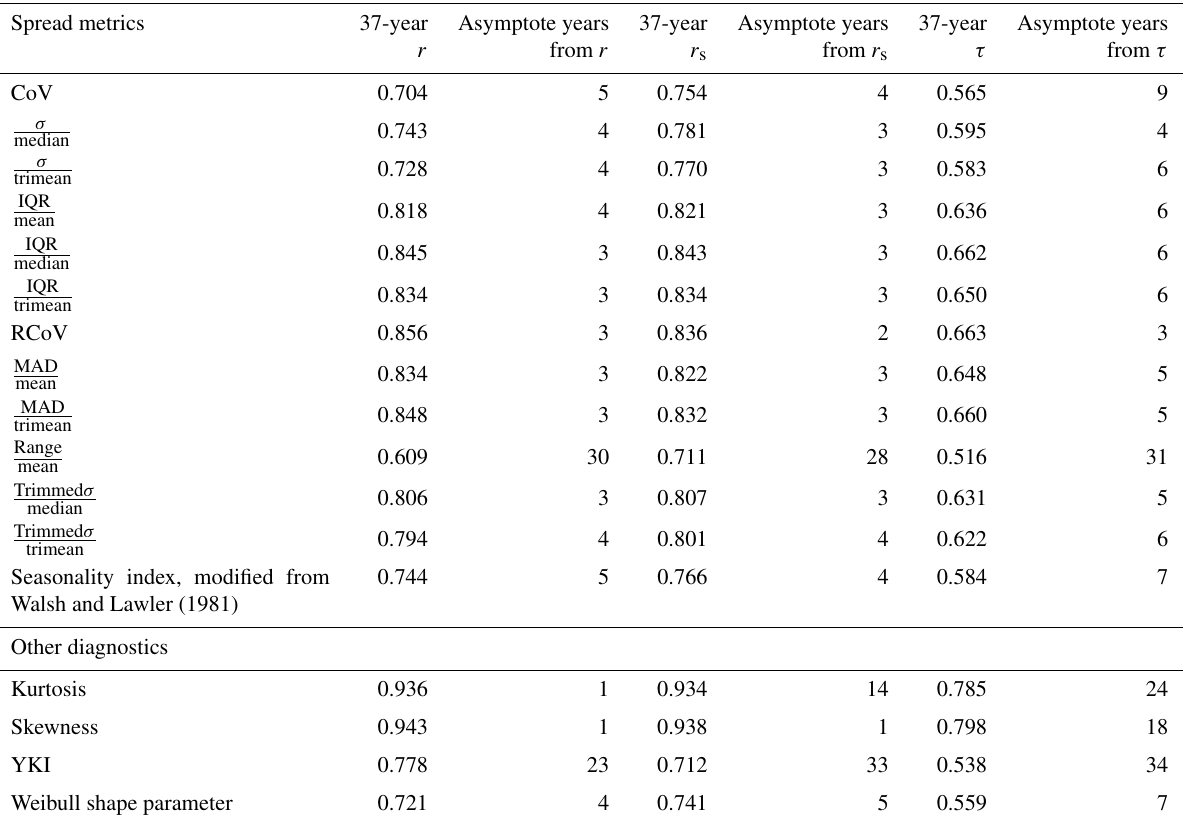
Table 3. Correlations and the associated asymptote periods of wind-speed variability and energy variability using various spread methods and distribution diagnostics with different correlation metrics, based on the monthly data of the 195 r -filtered wind sites. Spread